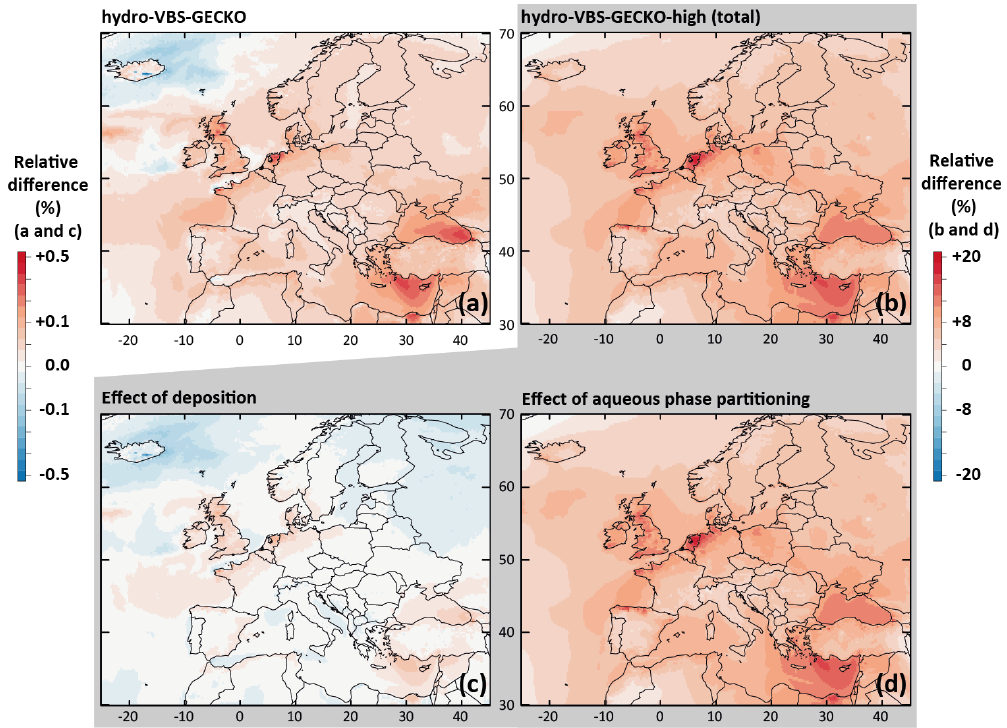
Figure 5. Relative differences on the simulated mean OA concentrations between (a) the Hydro-VBS-GECKO and the ref-VBS-GECKO and (b) the Hydro-VBS-GECKO-high and the ref-VBS-GECKO model configurations for the 2-month period. Bottom panels represent relative differences on the simulated mean OA concentrations between the Hydro-VBS-GECKO-high and the ref-VBS-GECKO due to variation in deposition (c) or partitioning (d) . Table 4. Statistical results calculated on daily averaged concentrations simulated with the various model configurations and differences with the ref-VBS-GECKO configuration statistical indicators given Table